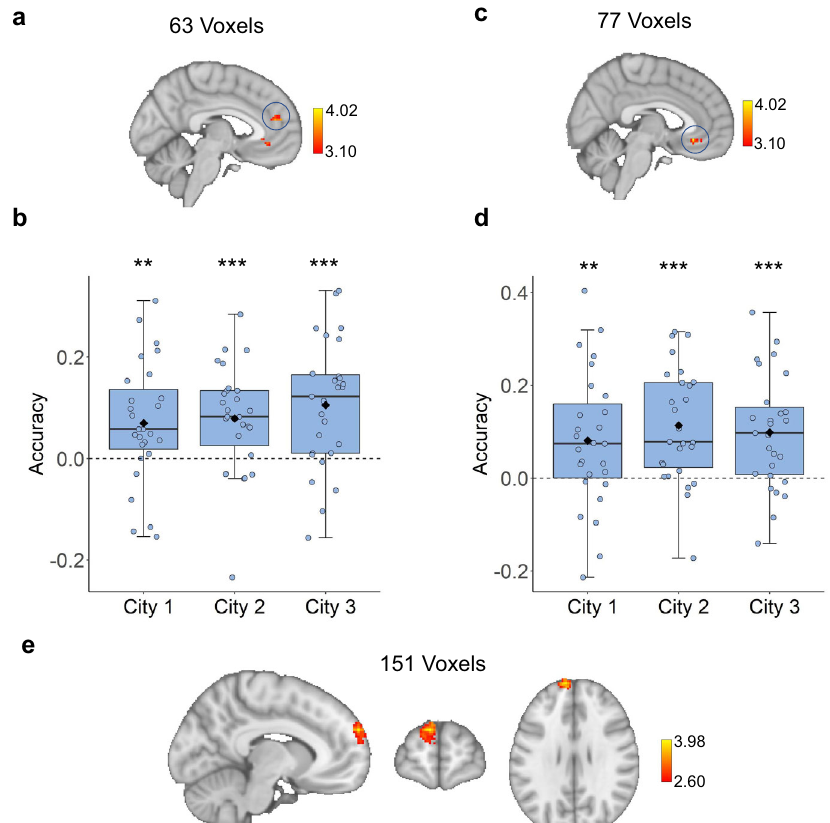
Fig. 4 Representation of schematic spatial layout information across environments in medial PFC. a The searchlight leave-one-city-out SVR classi fi cation revealed a more superior cluster (MNI: − 4, 50, 18, Z = 3.68) in mPFC whose spatial distances generalized from training on two cities to a third one (a random-effects model was used for group analyses within the mPFC mask using a cluster-forming threshold of Z > 3.10, with p < 0.05 (corrected for family-wise error rate, using random fi eld theory). b The SVR performance for each city in superior mPFC revealed above chance performance on cities 1, 2, and 3 (City 1: p = 0.005, City 2: p < 0.001, City 3: p < 0.001, two-tailed one-sample t -test with FDR correction, compared to chance level of 0). c The searchlight leave-one-city-out SVR classi fi cation revealed a more ventral cluster (MNI: − 10, 34, − 4, Z = 4.02) in mPFC whose spatial distances generalize from training on two cities to a third one (a random-effects model was used for group analyses across within the mPFC mask using a cluster-forming threshold of Z > 3.10, with p < 0.05 (corrected for family-wise error rate, using random fi eld theory). d The SVR performance for each city in ventral mPFC revealed above chance performance on cities 1, 2, and 3 (City 1: p = 0.008, City 2: p < 0.001, City 3: p < 0.001, two-tailed one- sample t -test with FDR correction compared to chance level of 0). e The searchlight revealed a signi fi cant cluster located in medial frontal pole (MNI: − 8, 62, 28, Z = 3.98) whose between-city PS for the same locations was higher than for different locations (a random-effects model was used for group analyses within the mPFC mask using a cluster-forming threshold of Z > 2.60, with p < 0.05 (corrected for family-wise error rate, using random fi eld theory). Notes: Boxplots are centered on the median, boxes extend to fi rst and third quartiles, whiskers extend to 1.5 times the interquartile range or minima/maxima in the absence of outliers. Each un fi lled dot represents data from an individual subject. Each black solid diamond represents the mean of the group. All data re fl ect n = 27 independent participants. mPFC medial prefrontal cortex, SUB subiculum. ** p < 0.01, *** p < 0.001. Source data are provided in the Source Data fi